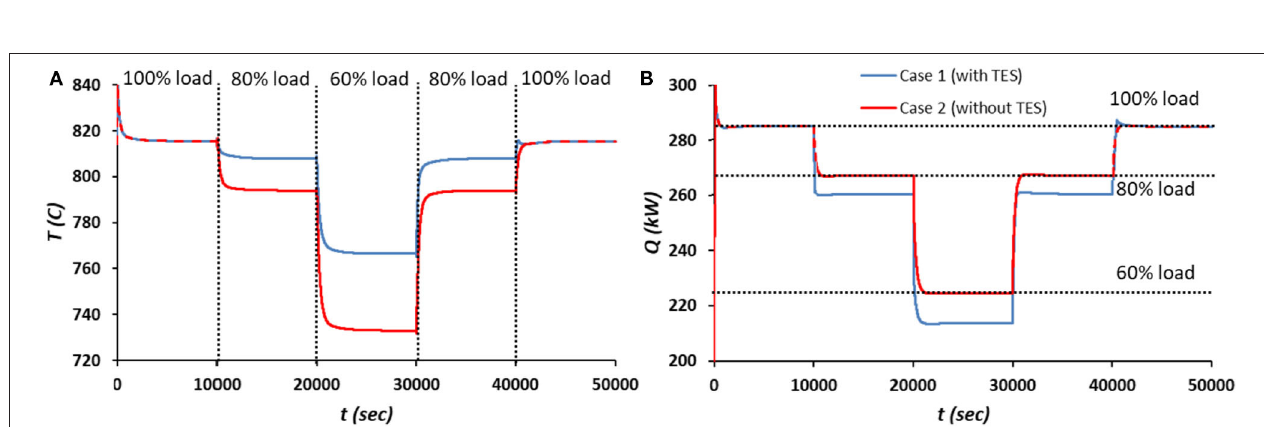
FIGURE 10 | Temporal evolution of the (A) average temperature of the CFB and (B) heat removed by the lances, as predicted by the transient simulation of 100–80–60–80–100% load changes for the two cases (with and without TES). The heat loads are shown in the image as well.